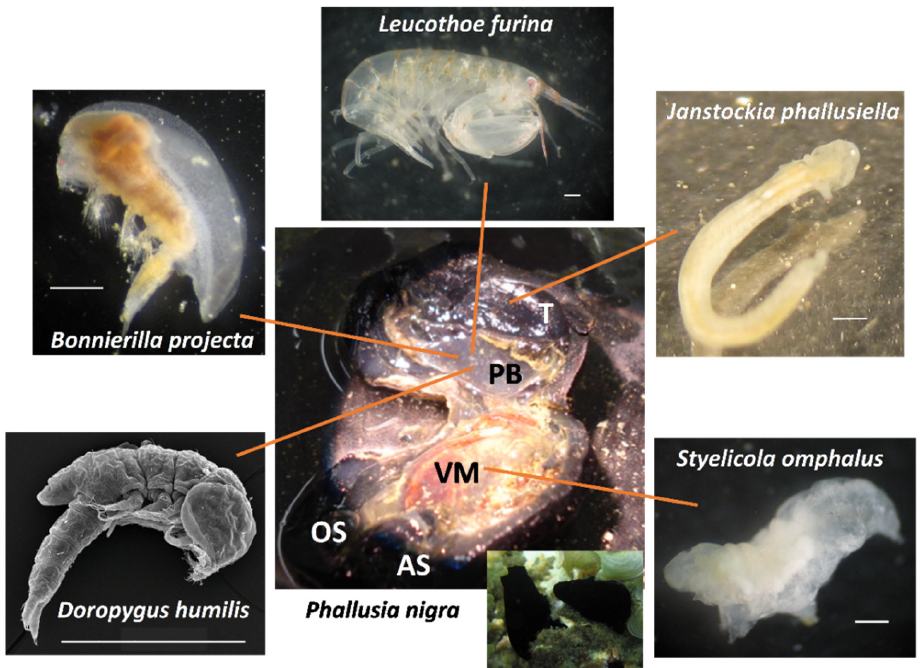
Figure 2. Symbionts found in the ascidian Phallusia nigra from the Egyptian Red Sea coast. Lines point the typical location of the symbiont inside the host. At the center, a dissected P. nigra (length 4.5 cm) is shown with part of the pharyngeal basket removed to expose the inside of the tunic: OS = oral siphon, AS = atrial siphon, PB = pharyngeal basket, T = tunic, VM = visceral mass. Two living specimens of the ascidian are shown in the insert. The scale bars for all symbionts are 0.5 mm. All photos by E. Cruz-Rivera, except D. humilis (by Kolbasov, G.A.).